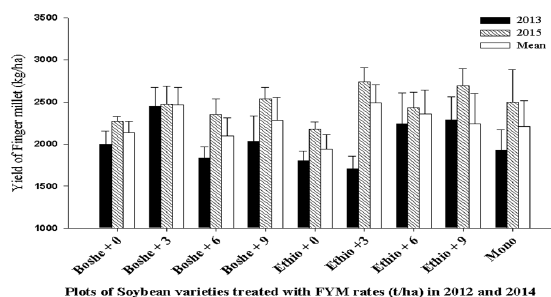
Figure 7. Residual effects of precursor soybean crop and applied FYM on the yield of the subsequent finger millet crop at Bako, Western Ethiopia. Mono F.M = farmers’ practice, continuous mono-cropping of finger millet with the recommended use of DAP fertilizer.